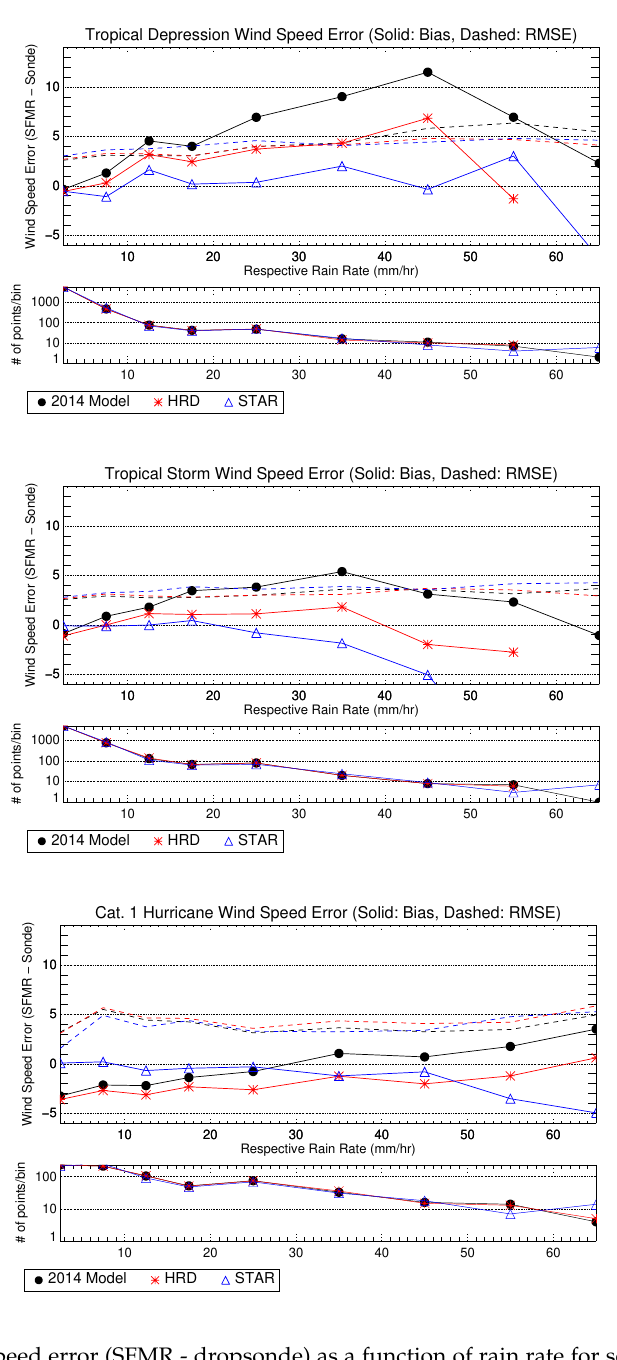
Figure 11. Wind-speed error (SFMR - dropsonde) as a function of rain rate for selected wind-speed regimes. From top to bottom the rows show results from tropical depression conditions (9 to 17ms − 1 ), tropical storm conditions (14 to 22ms − 1 ), and hurricane conditions (29 to 37ms − 1 ). The plots show wind-speed error means (solid lines) and RMS errors (dashed lines) versus the retrieved rain rate for the authors’ implementation of the 2014 model [8], the HRD retrievals, and the STAR algorithm. Differences between the “2014 model” and the HRD retrievals suggest a rain-rate-dependent wind-speed correction is being applied to the HRD